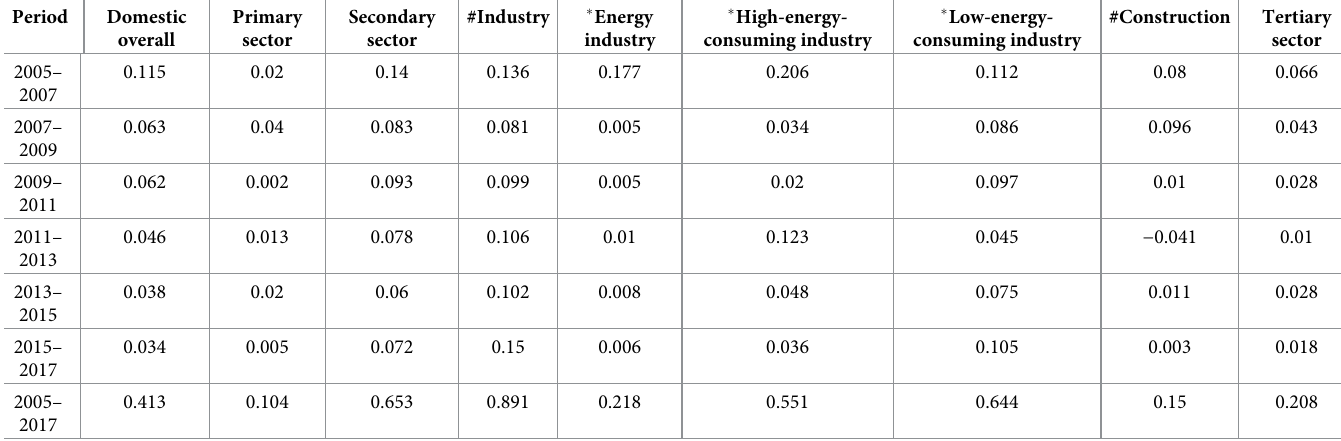
Table 3. The GTFP of China’s domestic overall, three sectors, and various industries within the secondary sector during 2005–2017. Period Domestic